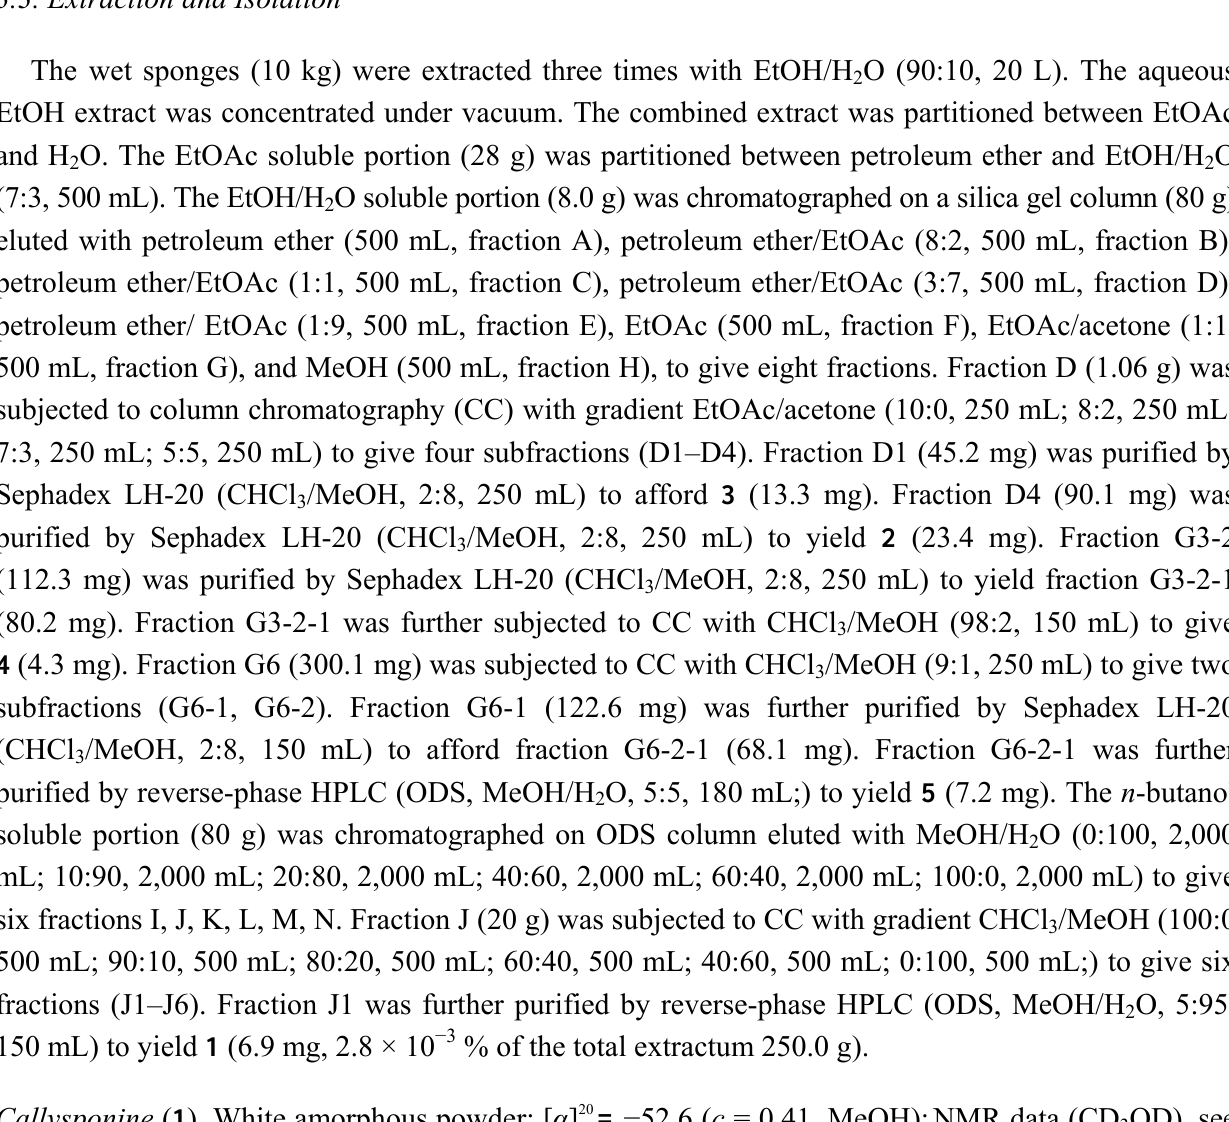
Table 1; ESI-MS ( m/z ): 237 [M+Na] + , 213 [M-H] − ; HREIMS ( m/z ): 214.0774 [M] + (calc.